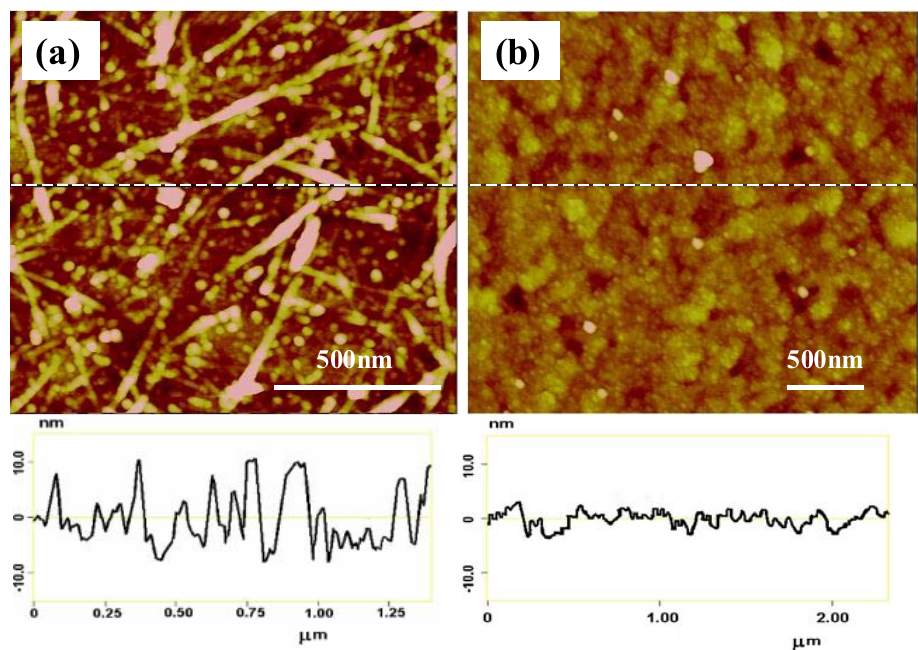
Figure 6. TappingMode AFM surface scans of electrochemically generated: (a) PABA/ss- DNA/SWNT composite film and (b) PABA film on gold